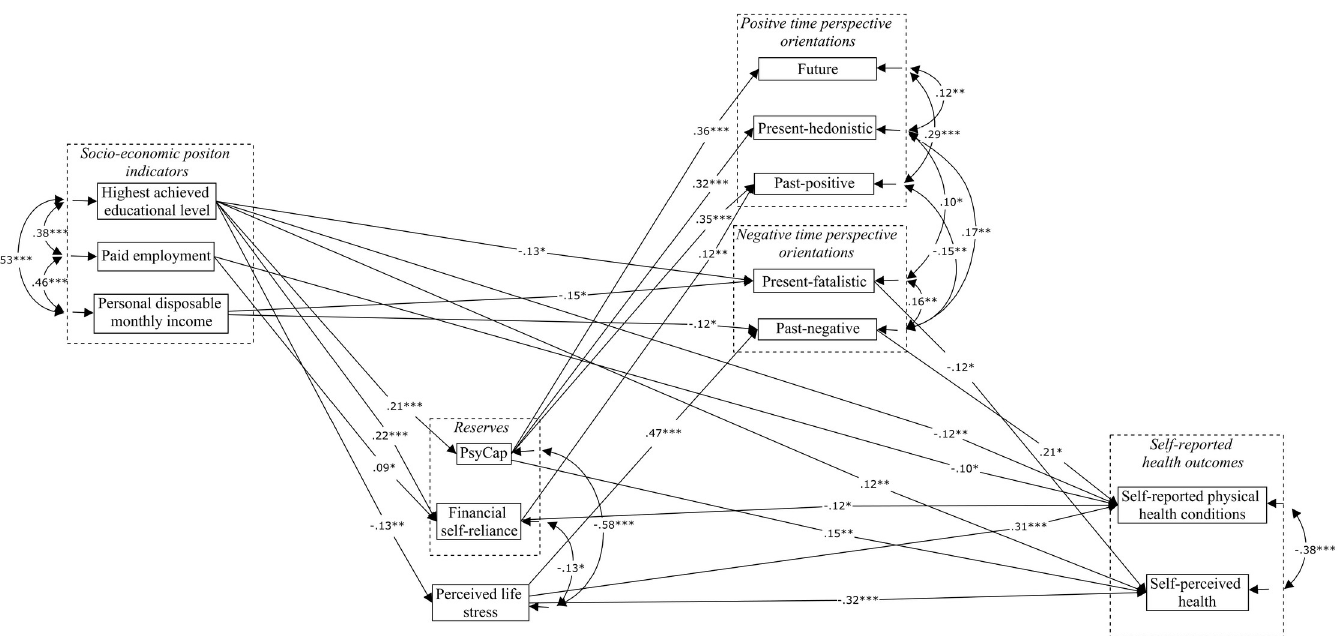
Fig 3. Significant model results. � p < .05; �� p < .01; ��� p < .001; RMSEA = .031; SRMR = .011; CFI = .997; PsyCap = Psychological capital; Although sex, age and background were included as covariates in the analysis at all model levels, model results regarding age, sex and background are not depicted in the Figure. Standardized (YX) significant results are displayed for all other model variables; Significant mediation effects were found for the following paths: H6a: Highest achieved educational level ! PsyCap ! self-perceived health; Highest achieved educational level ! financial self-reliance ! self-reported physical health conditions; H6b: Highest